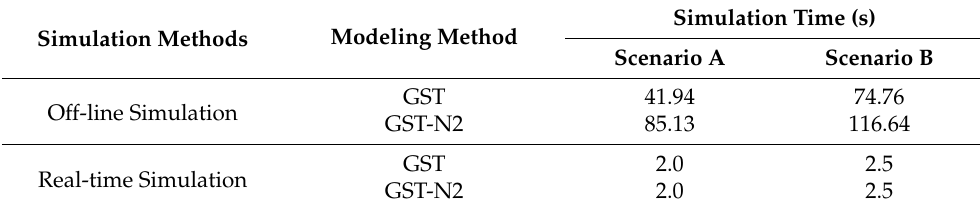
Table 3. Comparison of simulation time